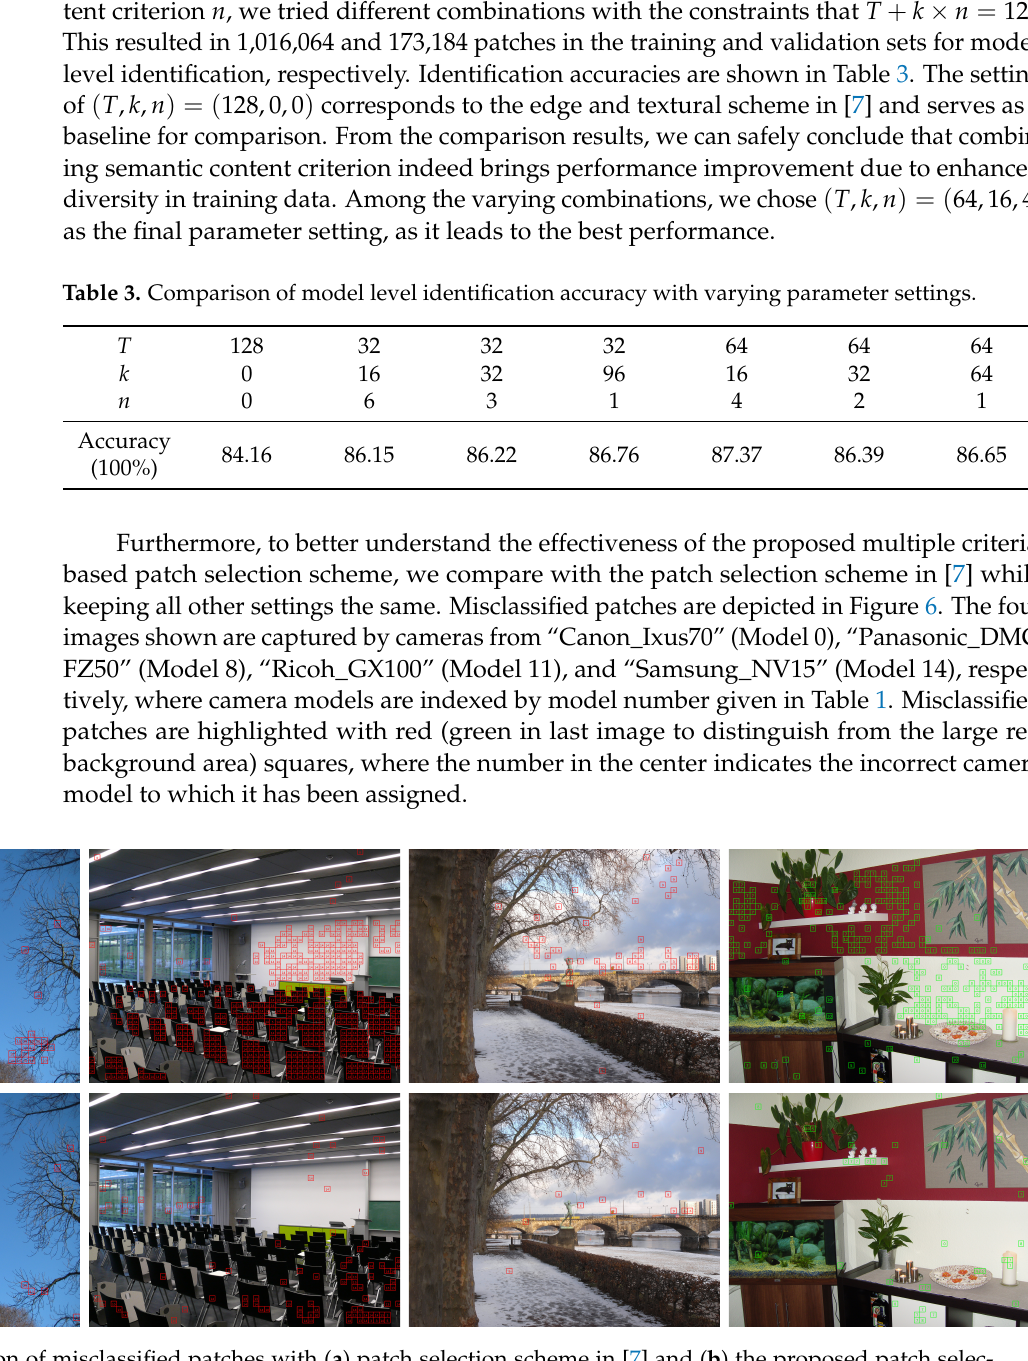
Figure 6. Visualization of misclassified patches with ( a ) patch selection scheme in [7] and ( b ) the proposed patch selec- tion